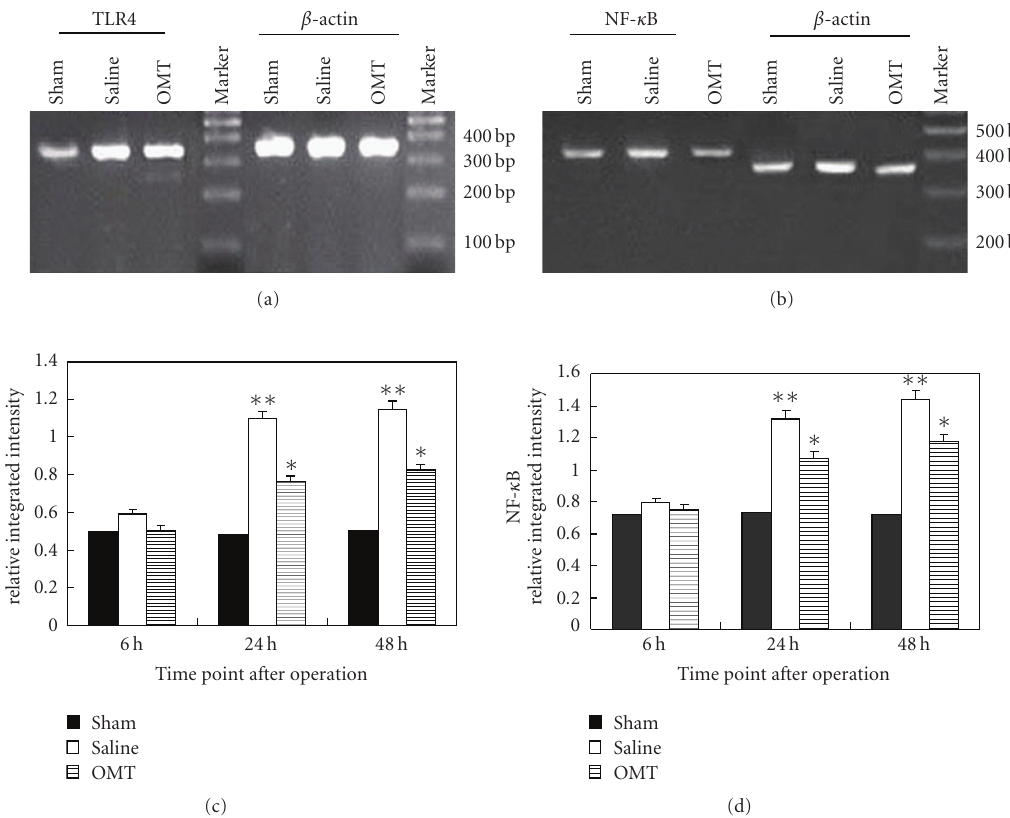
Figure 3: RT-PCR results of TLR4 and NF- κ B. (a) RT-PCR of TLR4 at 24 hours after the operation in each group: expression of TLR4 mRNA was evidently higher in the saline group compared with the OMT treatment group, and the di ff erence was significant ( P < . 05). (b) RT-PCR of NF- κ B 24 hours after the operation in each group: expression of NF- κ B mRNA was similar to that of TLR4 mRNA. (c) RT-PCR of TLR4 at all time points: expression of TLR4 mRNA showed no di ff erence among all test groups at 6 hours. It was evidently higher in the saline group at 12 hours and lasted up to 48 hours. Compared with the saline group at identical time points, expression of TLR4 mRNA was lower in the OMT treatment group, and the di ff erence was significant ∗∗ P < . 01 and ∗ P < . 05 compared with Sham. (d) RT-PCR of NF- κ B at all time points: expression of NF- κ B mRNA was similar to that of TLR4 mRNA ∗∗ P < . 01 and ∗ P < . 05 compared with